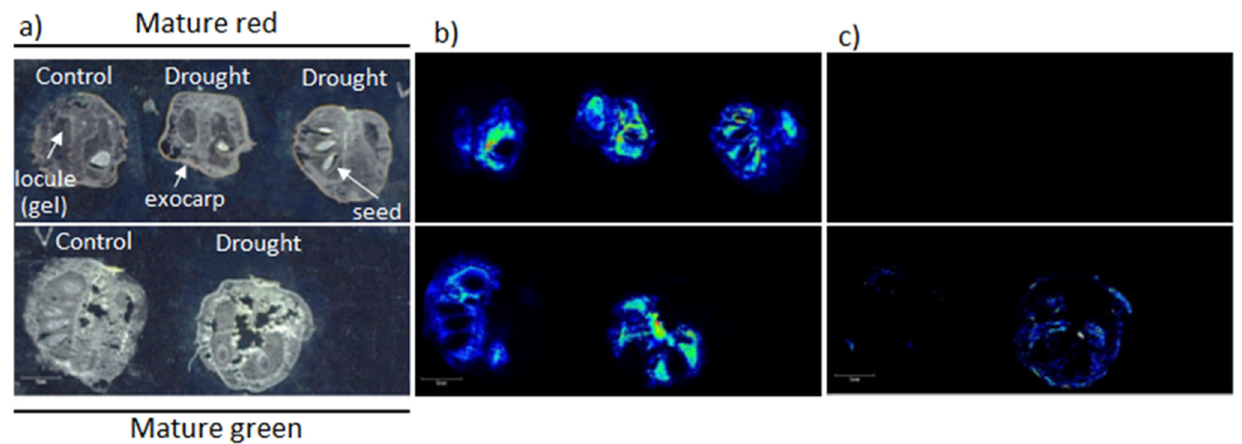
Figure 3. Mass spectrometry imaging of functional ingredients in tomato fruits during ripening under drought stress. ( a ) Bright-field images of control or drought-stressed fruits. ( b , c ) Mass spectrometry imaging of β -Alanine +Na m / z 112 ( b ) and tomatidine +H m / z 416 ( c ).